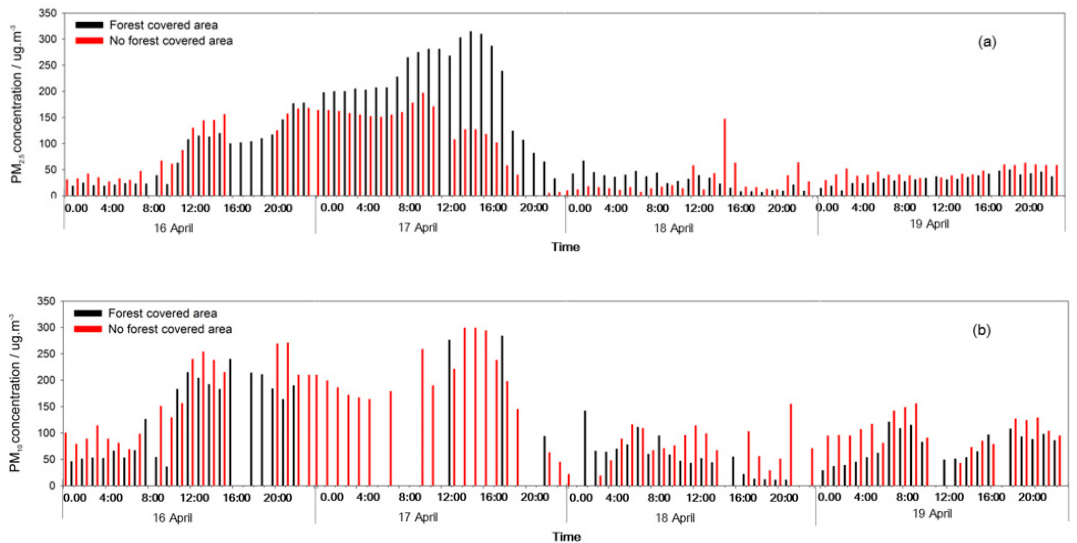
Figure 8. PM 2.5 ( a ) and PM 10 ( b ) concentrations changes in light pollution event.